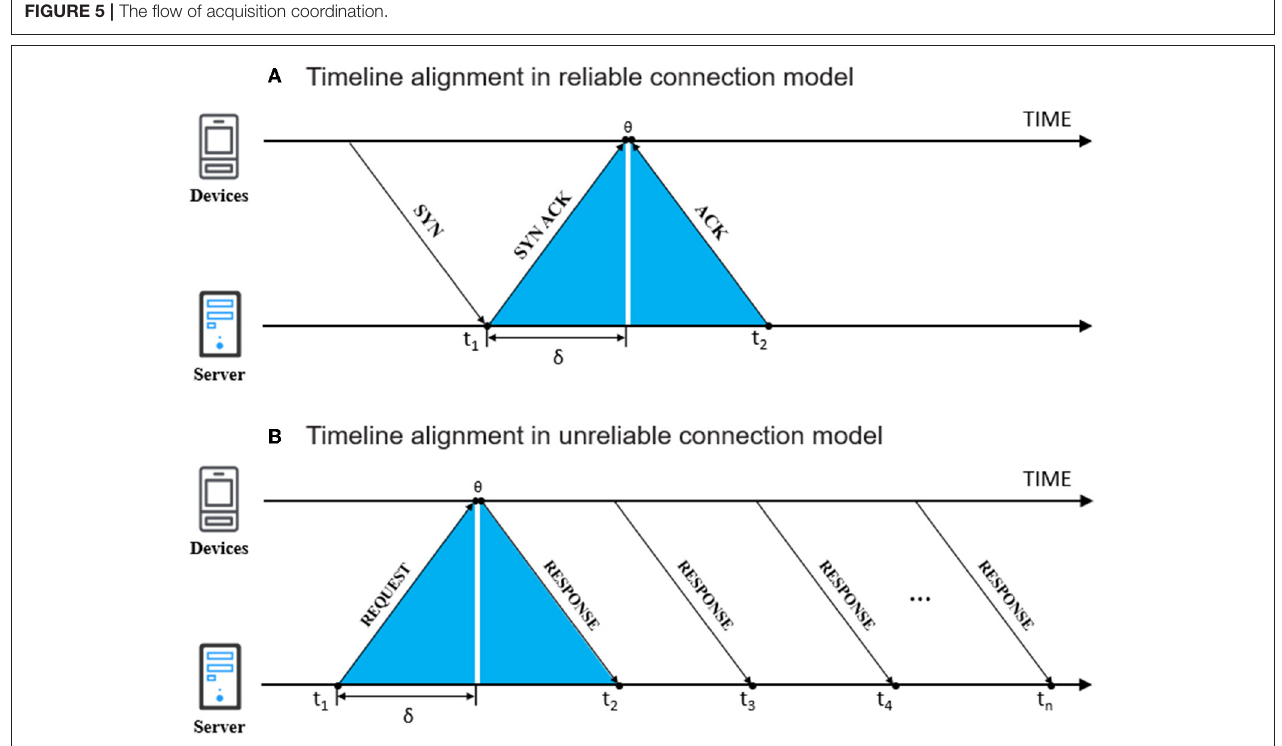
FIGURE 6 | The timeline alignment strategy in two model.